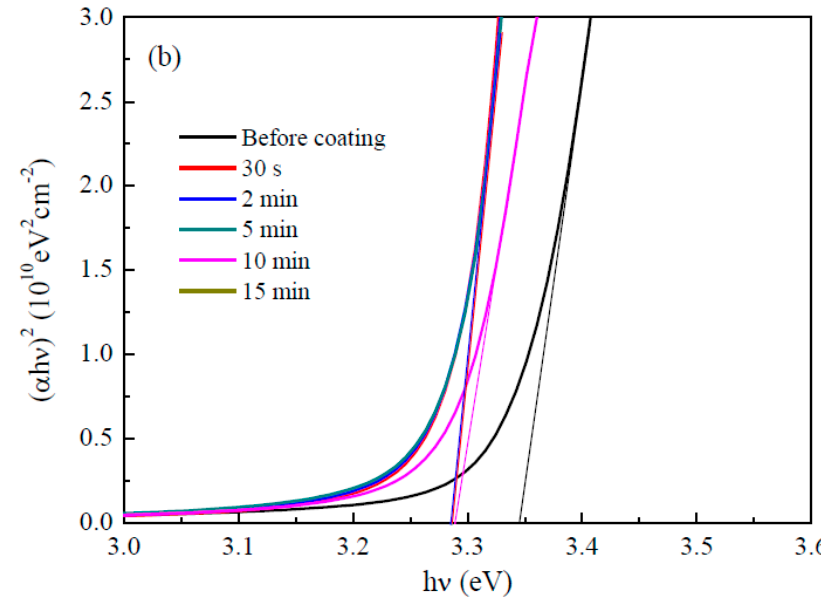
Figure 7. ( a ) Transmission spectra of the as-deposited ZnO nanorods and ZnO nanorods coated with TiO 2 by mist CVD; and ( b ) variation of ( ah ν ) 2 of the as-deposited ZnO nanorods and ZnO nanorods coated with TiO 2 as a function of the photon energy ( h ν